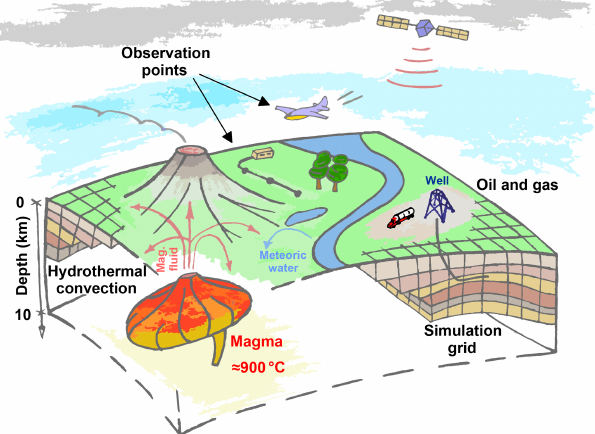
Figure 1. Sketch of typical processes in hydrothermal systems (left) and petroleum reservoirs (right). Magma degassing results in a plume of hot magmatic fluid. Near the surface, the fluid can mix with colder meteoric water. The observation points, where the ground displacement and gravity changes can be measured, are